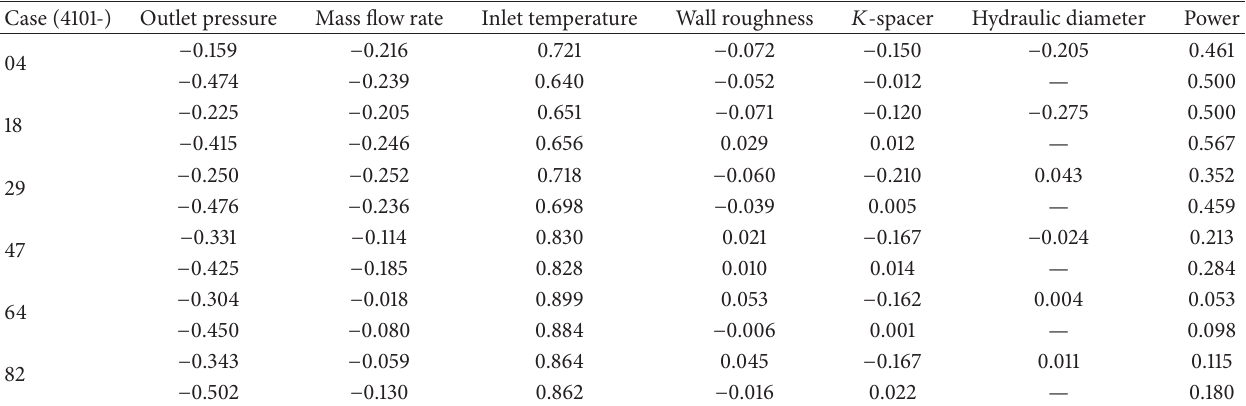
Table 8: Sensitivity coefficients for the void fraction